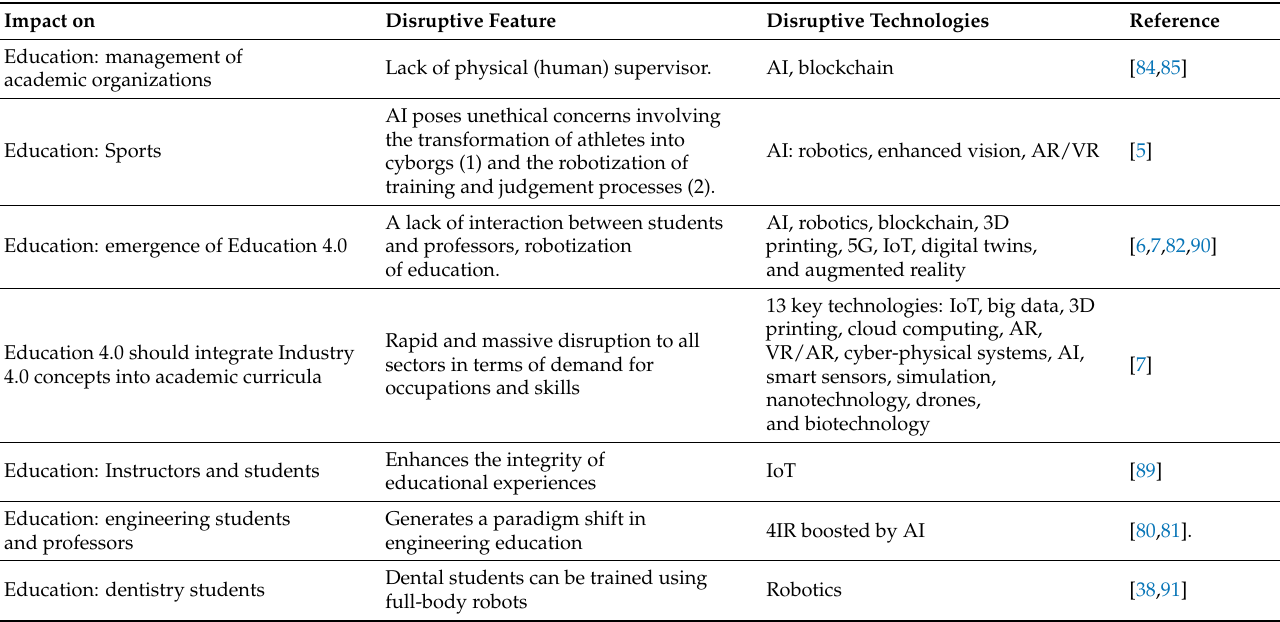
Table 11 reveals the disruptive features and technologies that impact education. Table 11. Disruptive use of technologies (especially AI) in